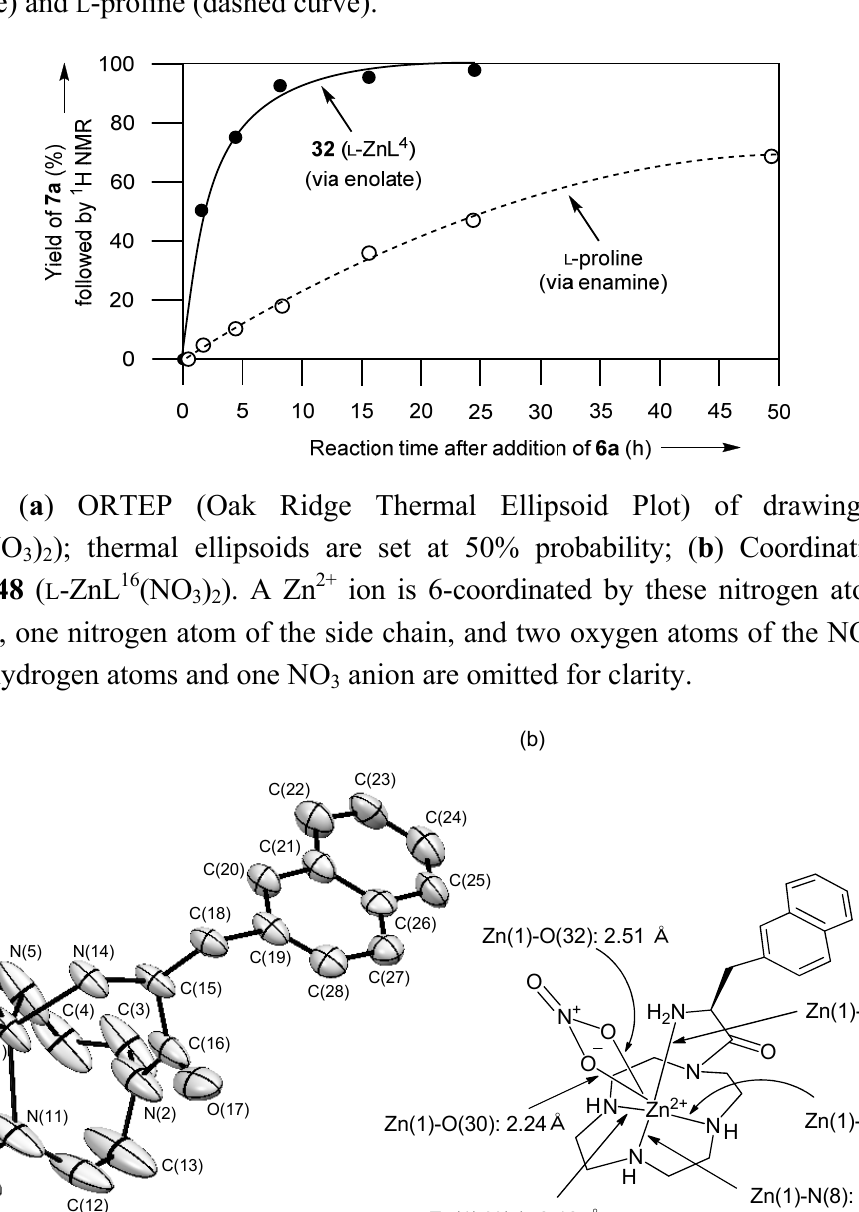
Figure 4. Change in the yield of 7a followed by 1 H-NMR in the presence of 32 ( L -ZnL 4 ) (plain curve) and L -proline (dashed curve).